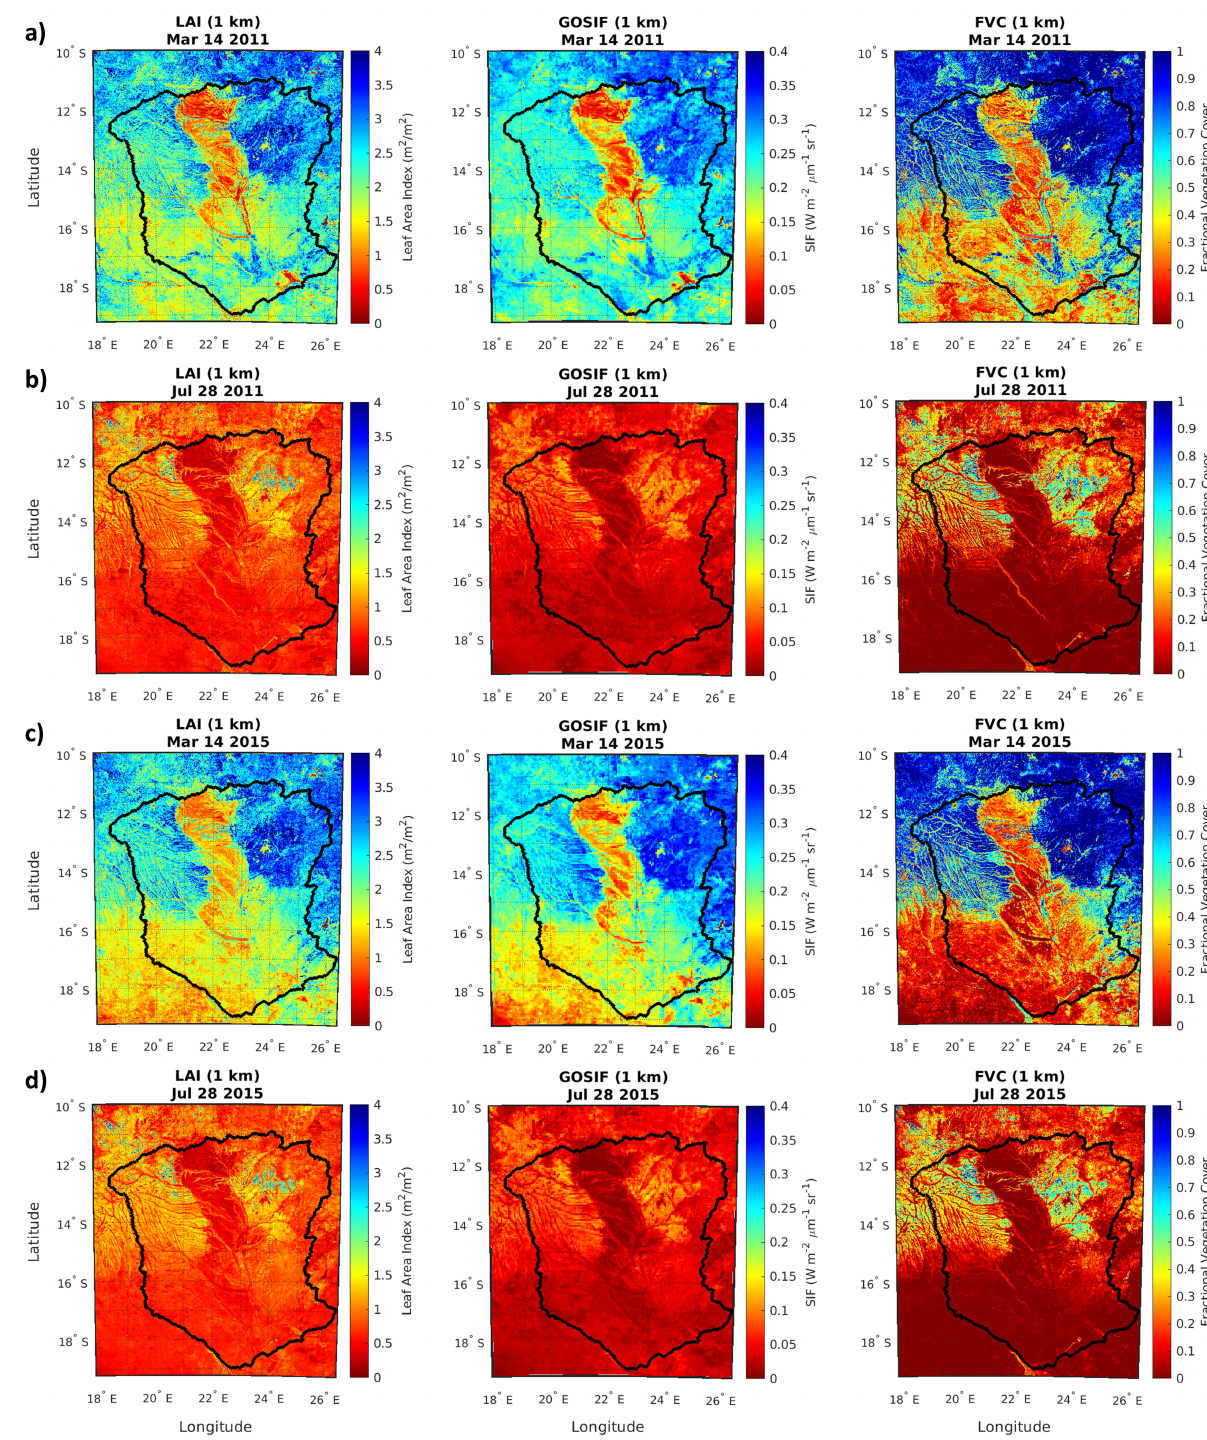
Figure 10. Spatial comparisons of ( a , b ) 2011 and ( c , d ) 2015 Leaf Area Index (LAI), Solar-Induced chlorophyll Fluorescence (SIF), and Fractional Vegetation Cover (FVC) ( a , c ) just after the peak of the rainy season and ( b , d ) during the middle of the dry